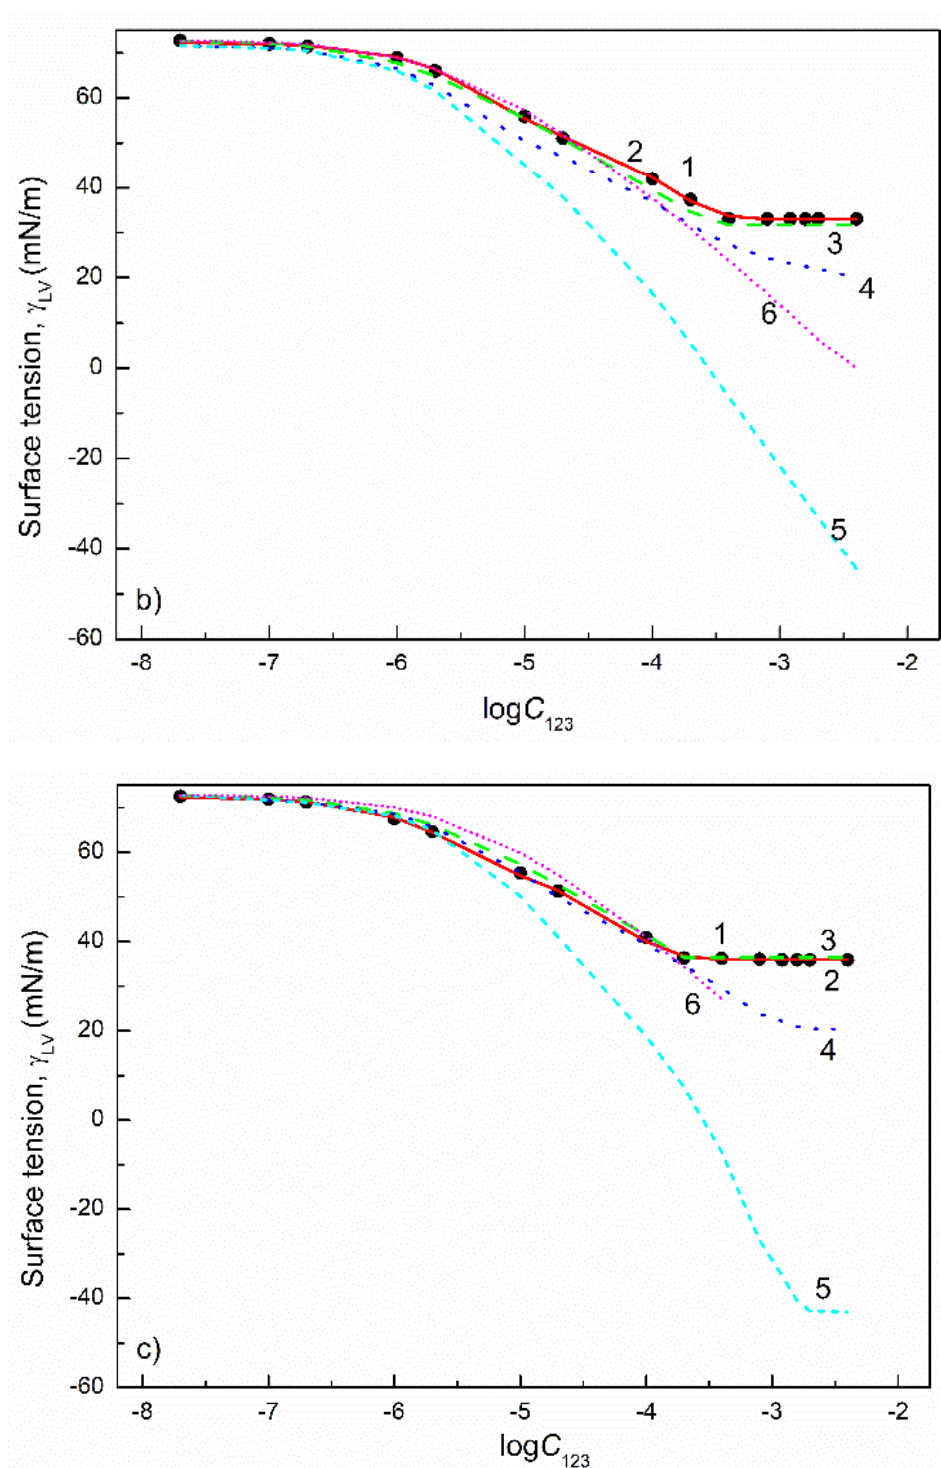
Figure 12. A plot of the surface tension ( γ LV ) of the aqueous solutions of CTAB(0.3)+TX100(0.5)+TX114(0.2) ( a ), CTAB(0.25)+TX100(0.25)+TX114(0.5) ( b ) CTAB(0.5)+TX100(0.25)+TX114(0.25) ( c ) mixtures vs. the logarithm of their concentration ( logC 123 ). Points 1 correspond to the measured values [31], curves 2–6 correspond to the values calculated from the exponential function of the second order (Equation (2)), Szyszkowski equation (Equation (3)), Fainerman and Miller equation (Equation (11)), independent adsorption (Equation (15)) and Joos equation (Equation (13)), respectively.